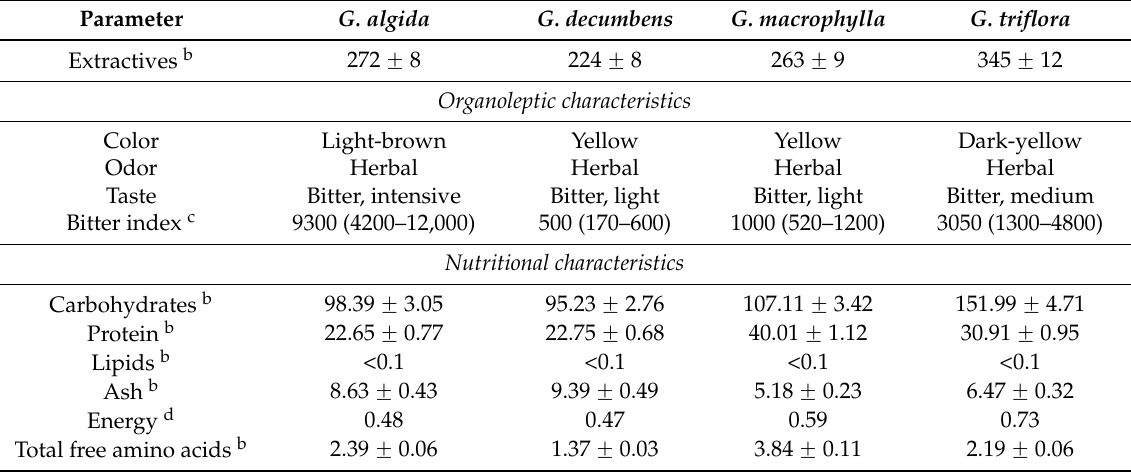
Table 1. Organoleptic and nutritional characteristics of four gentian tea decoctions a